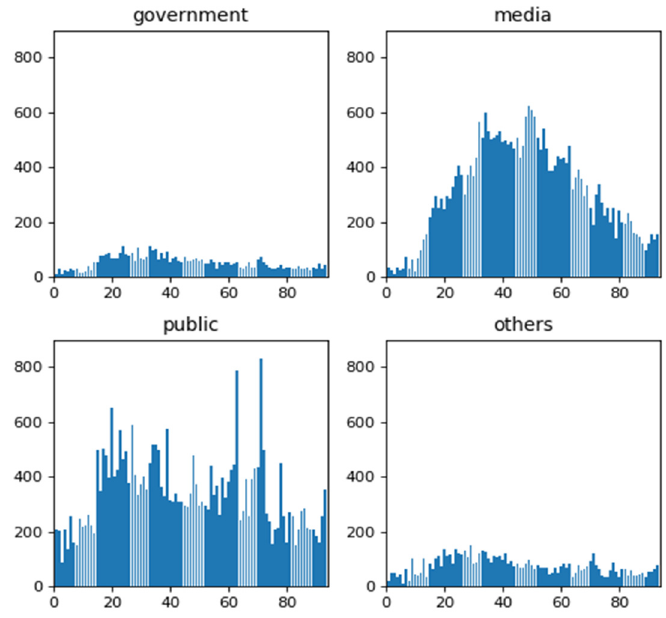
Figure 2. Time series of the volume of